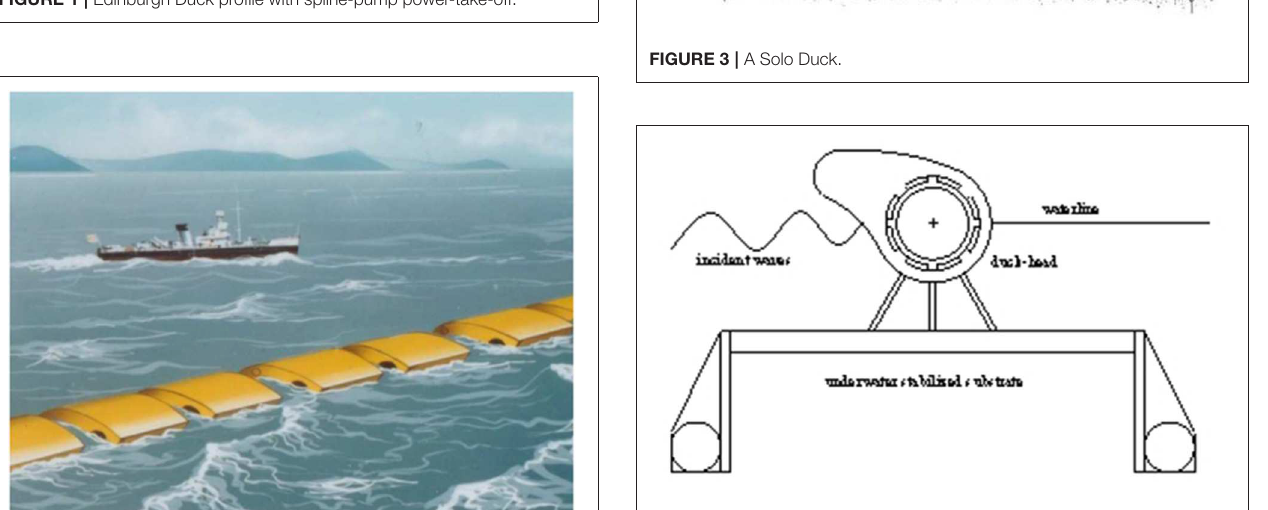
FIGURE 1 | Edinburgh Duck profile with spline-pump power-take-off.